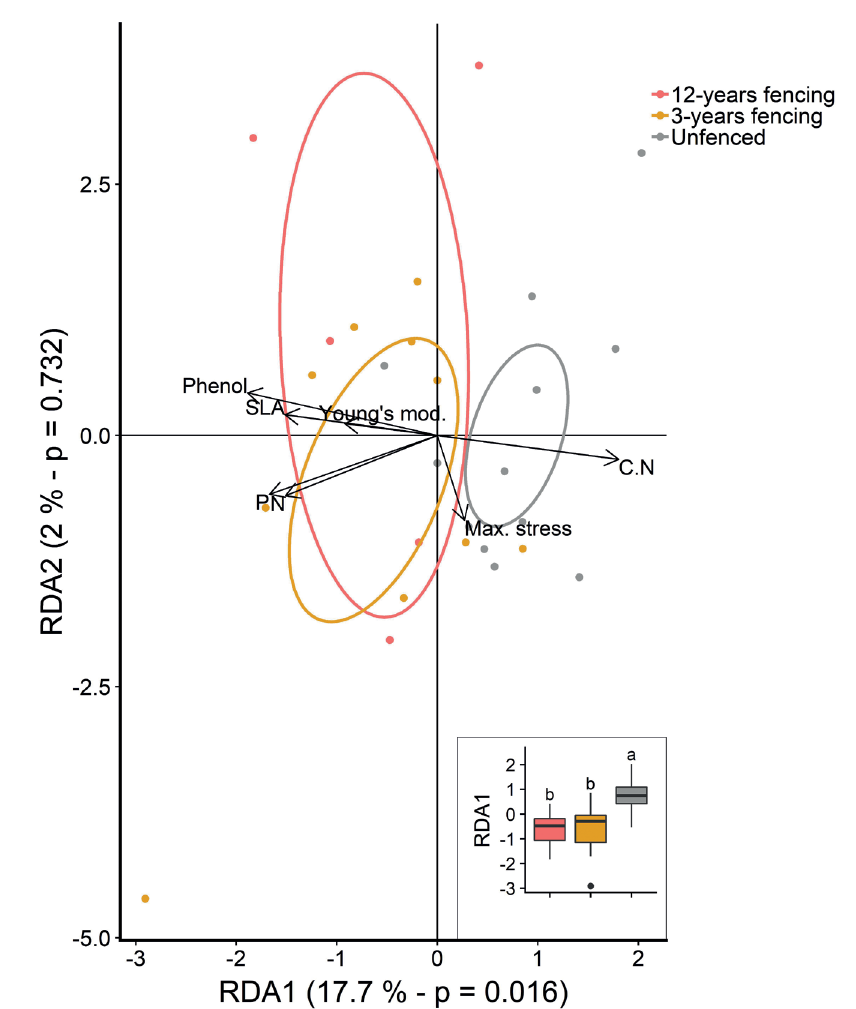
Figure 3 – Scatter diagram of the two first axes of the partial RDA testing the effect of the fencing treatment on silver fir functional traits [traits ~ Fencing + Condition( experimental unit )]. The traits included in the RDA are SLA, C:N ratio, N and P content, phenolic content, Young’s modulus and maximum stress. RDA 1 and RDA 2 respectively stand for 1 st and 2 nd axis of the RDA. The fencing factor is represented by standard-error ellipses around group centroids with a confidence level of 0.95. The inset shows the differences in RDA1 coordinates between the three levels of the fencing treatment, tested by a one-way ANOVA followed by Tukey’s post-hoc